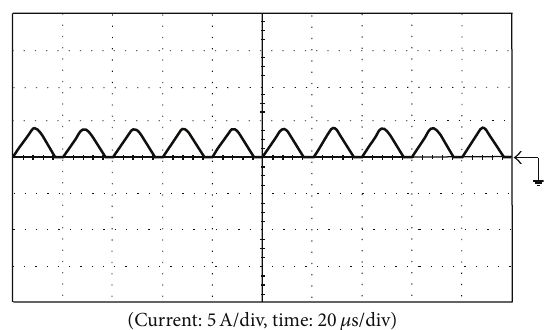
Figure 18: Measured output inductor current while PV panel provides 350W.